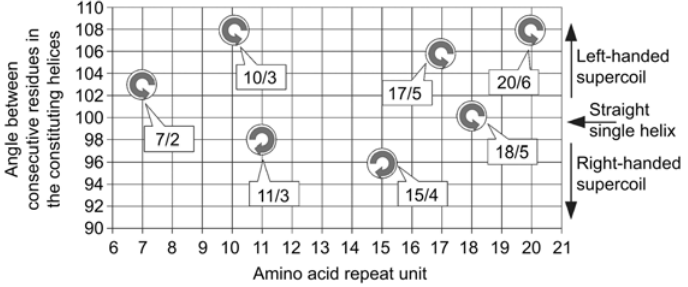
Figure 3 Relationships between repeat sequence, helical and superhelical parameters. The angle between consecutive residues in the constituent helices is calculated from the residue/turn ratios shown in the call-outs and are defined relative to the supercoil axis. The diagram is based on the data and classification in Ref.